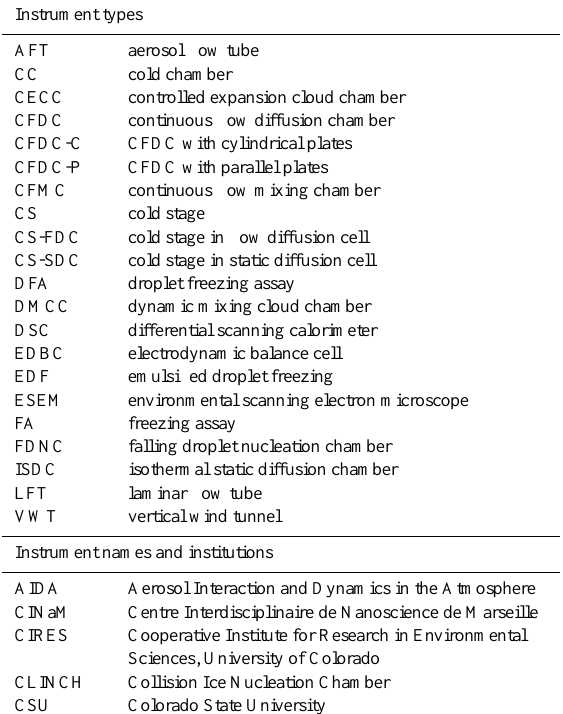
Table A2. List of